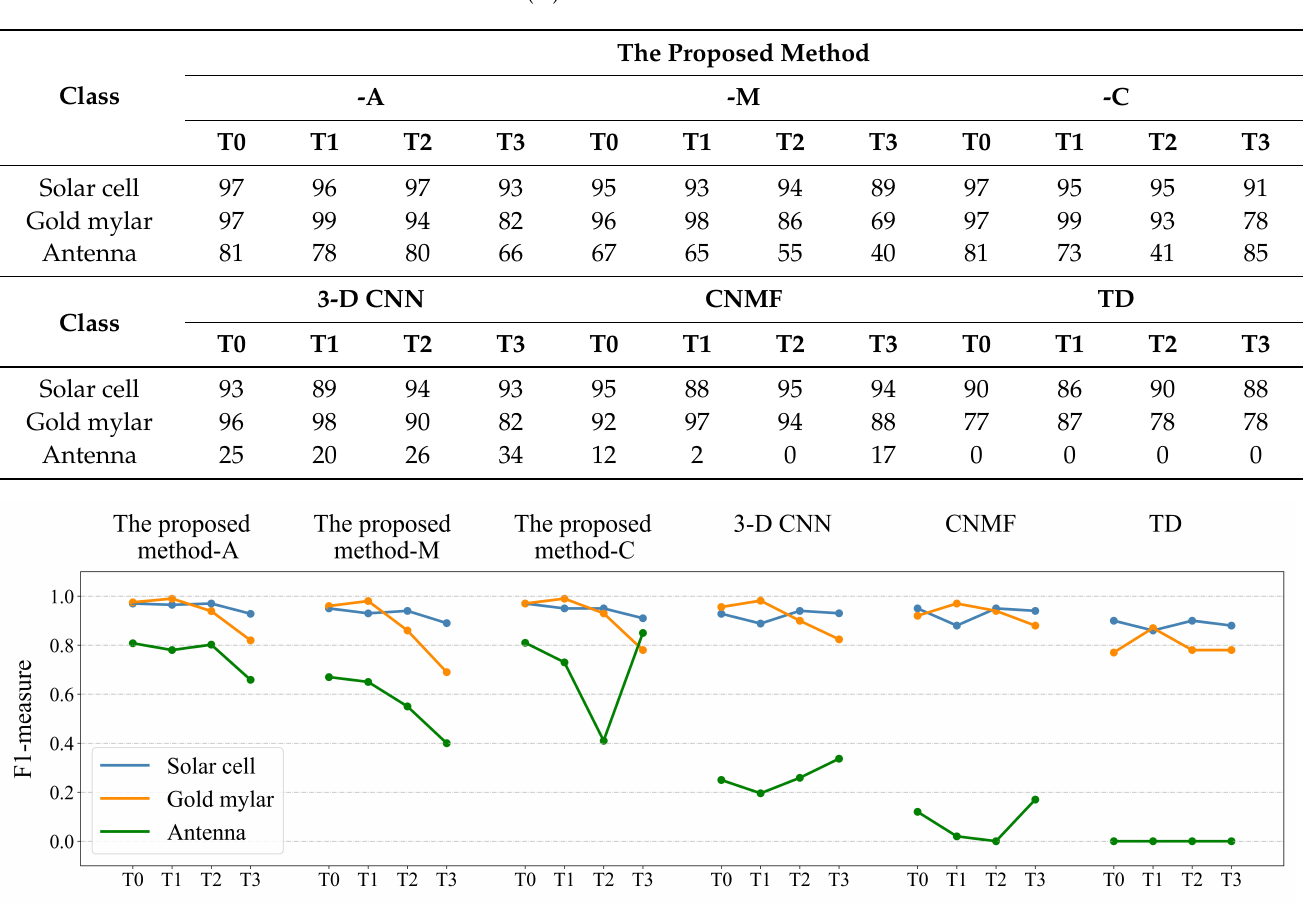
Figure 15. F1-measure chart of the simulated data.